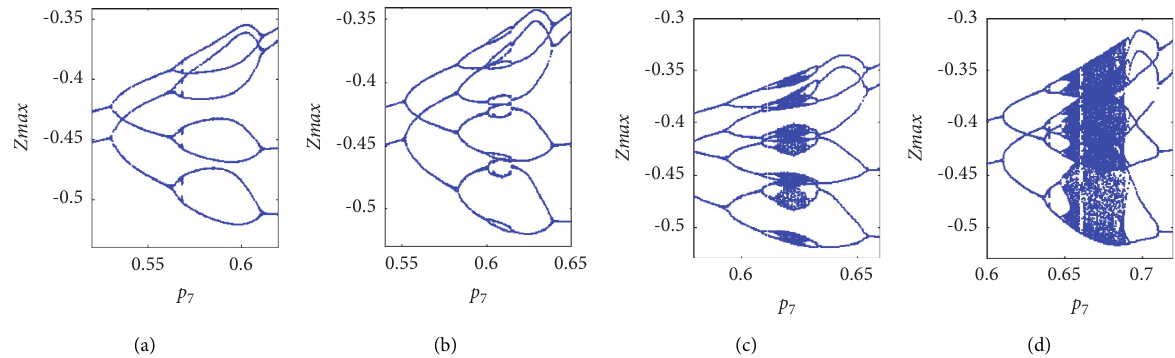
Figure 5: Bifurcation diagram for remerging Feigenbaum tree (bubbling): (a) period-2 bubble for p (c) and (d) full Feigenbaum remerging tree at p